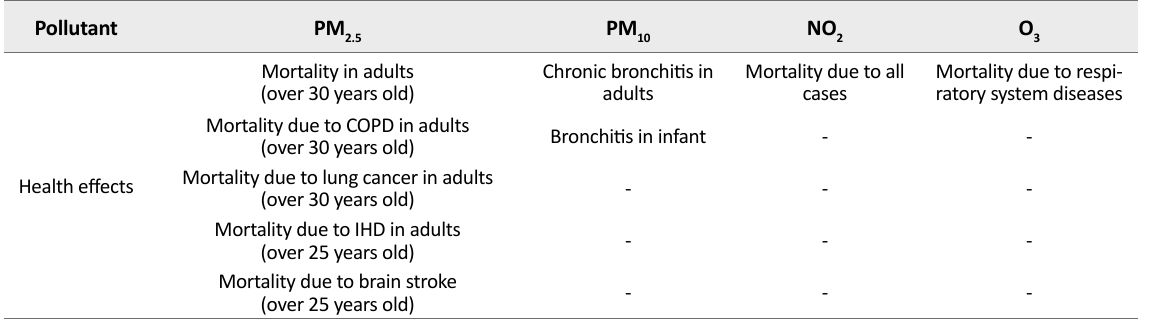
PM NO O 10 2 3 Chronic bronchitis in Mortality due to all Mortality due to respi- adults cases ratory system diseases